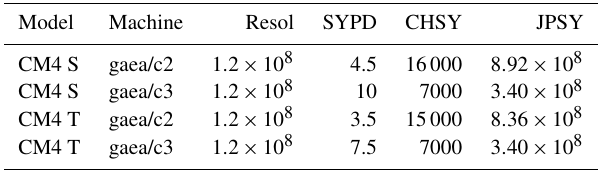
Table 3. Results comparing the same model in both speed (S) and throughput (T) mode on different